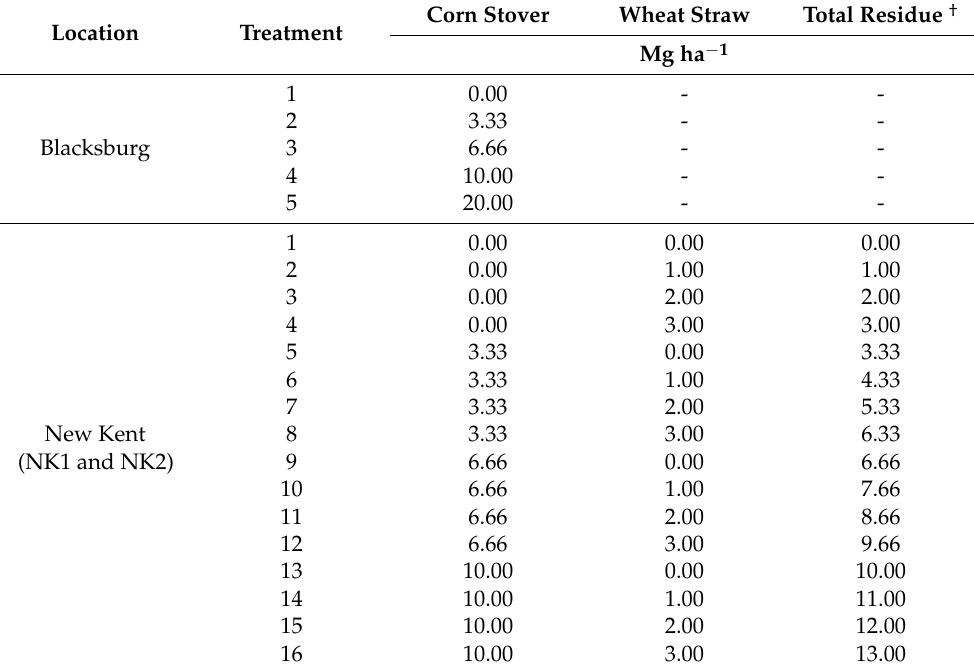
Table 1. Residue sources and retention rates for a field-based greenhouse gas emissions study in Blacksburg and New Kent, VA. Corn Location Treatment